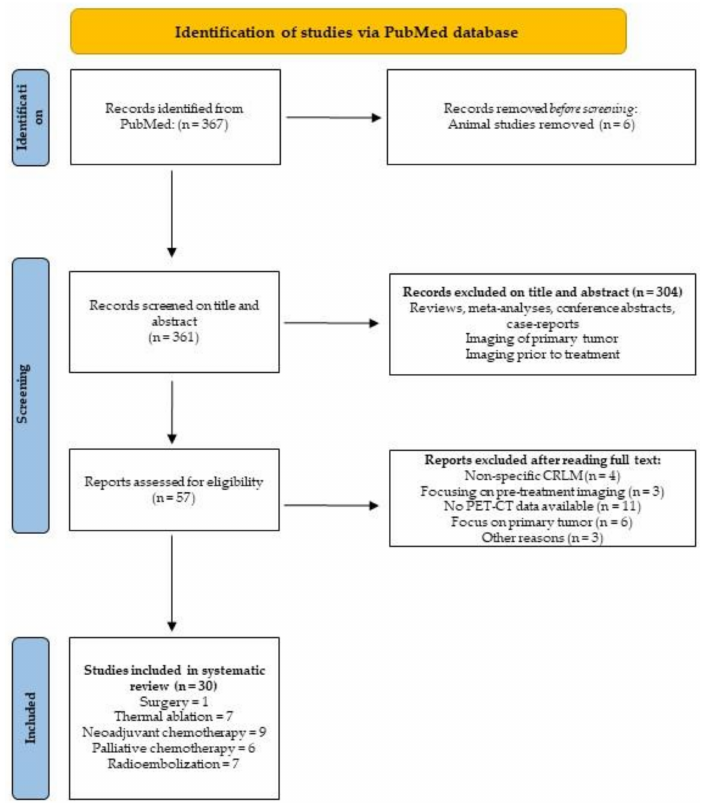
Figure 1. PRISMA flow